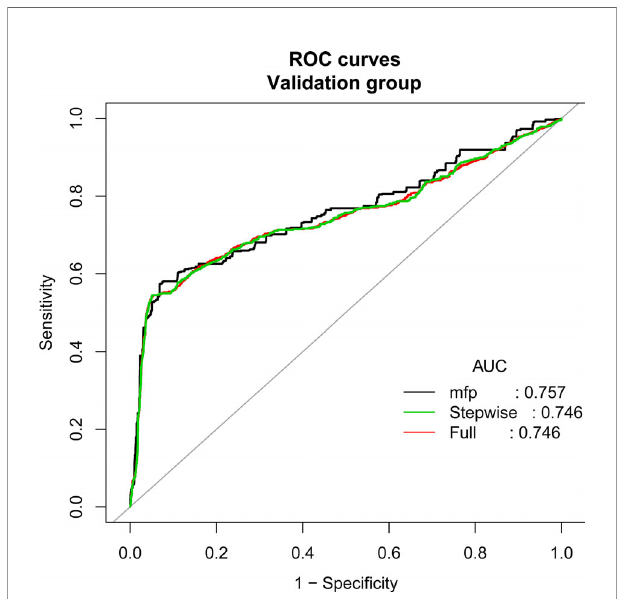
FIGURE 3 | Discrimination for the training cohort. The AUC (mfp) of the veri fi cation group is 0.757 (95%